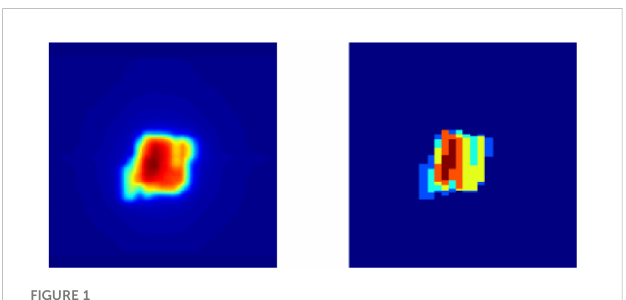
FIGURE 1 Left: 2D dose map of single beam viewed from beam ’ s eye view. Right: Sum of individual ground truth fi eld segments projected at